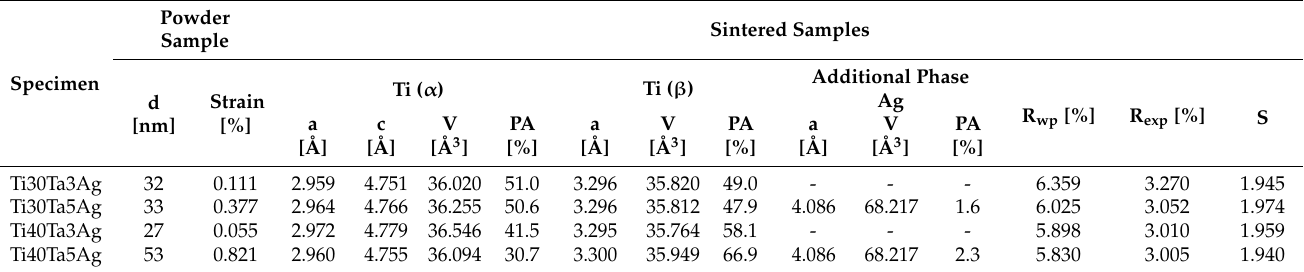
Table 1. The crystallographic data of the powders after mechanical alloying and after hot-pressing; d—crystallite size; a, c—lattice constant; V—lattice volume; PA—phase amount; R wp —weighted pattern residual indicator; R exp —expected residual indicator; and S—goodness of fit.